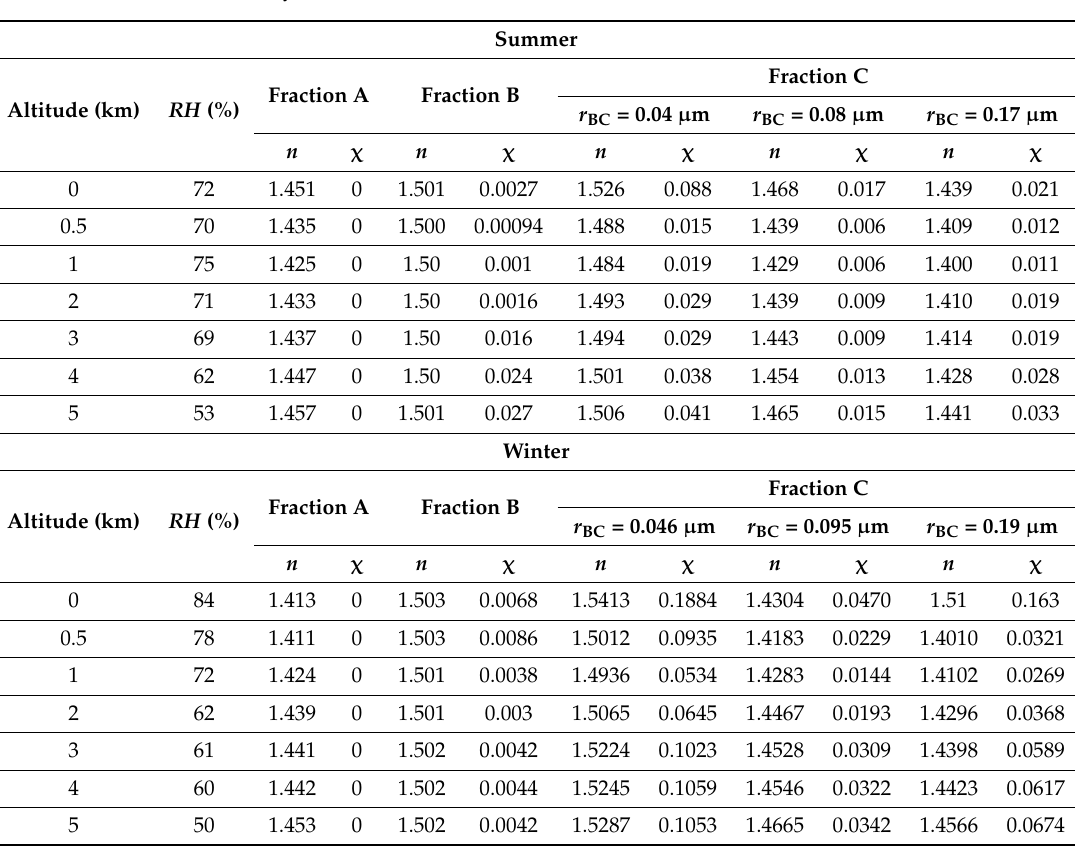
Table 2. Relative humidity and refractive indices of fraction at different altitudes in winter and summer. Summer